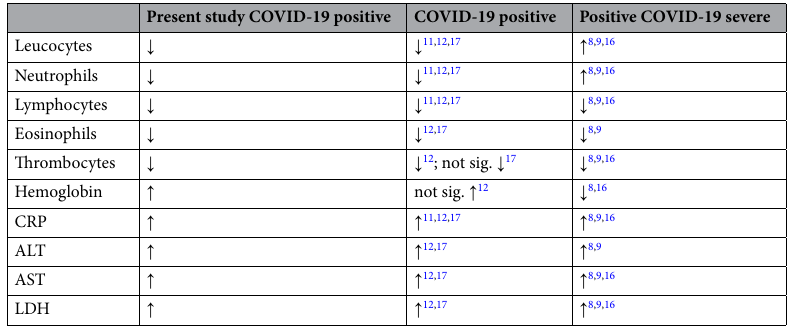
Table 6. Blood parameter patterns of COVID-19 positive tested patients of various studies. Abbreviations: ALT alanine aminotransferase, AST aspartate aminotransferase, CRP C-reactive protein, LDH lactate